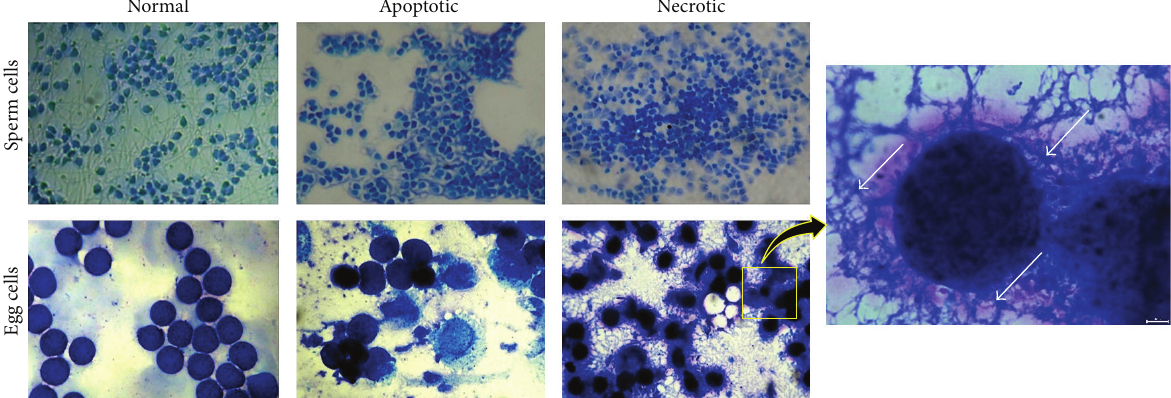
Figure 2: Representative images showing T. gratilla different gamete morphologies (400x). This network of thread-like blue material (white arrows) strongly indicates that there is a result of leaching DNA materials when a cell undergoes necrosis due to the attachment of Giemsa stain onto sites where adenine and thymine are